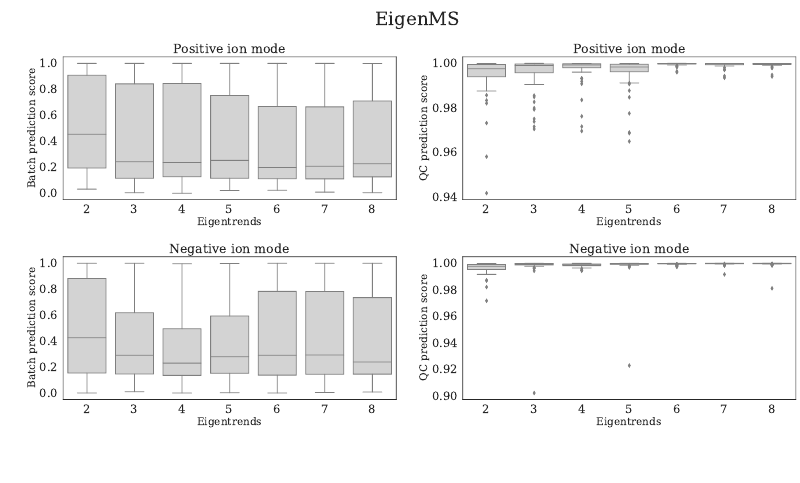
Figure 5. Each subfigure shows 4 panels which belong to the normalization method stated in the title. The upper, lower panels are the batch prediction scores and QC prediction scores (vertical axes) for various choices of the parameter (horizontal axis) for positive, negative ion mode, respectively. ( a ) RUVrand , ( b ) CCMN , ( c ) Fast Cyclic Loess , ( d ) EigenMS